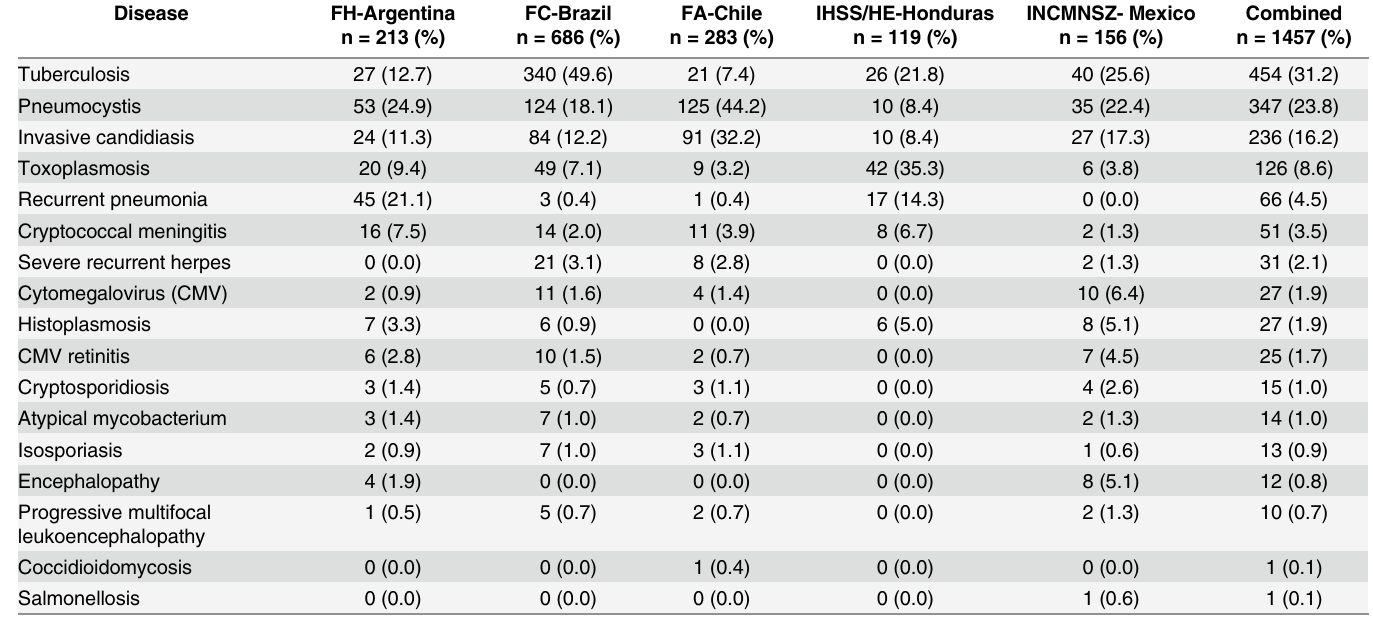
Table 2. Number of cases of each opportunistic infection reported according to site and combined.